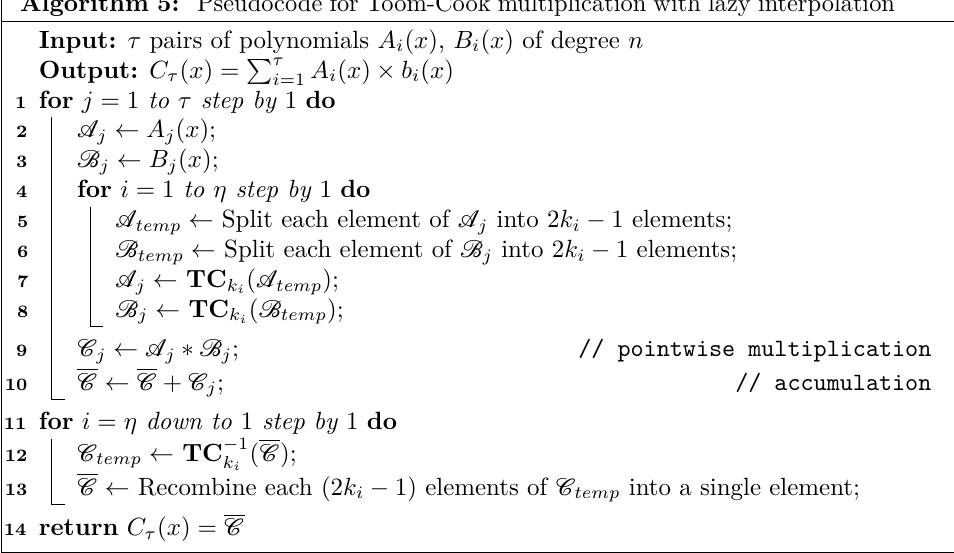
Algorithm 5: Pseudocode for Toom-Cook multiplication with lazy